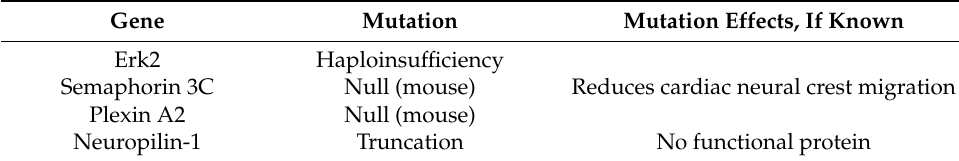
Table 2. Mutations associated with persistent truncus